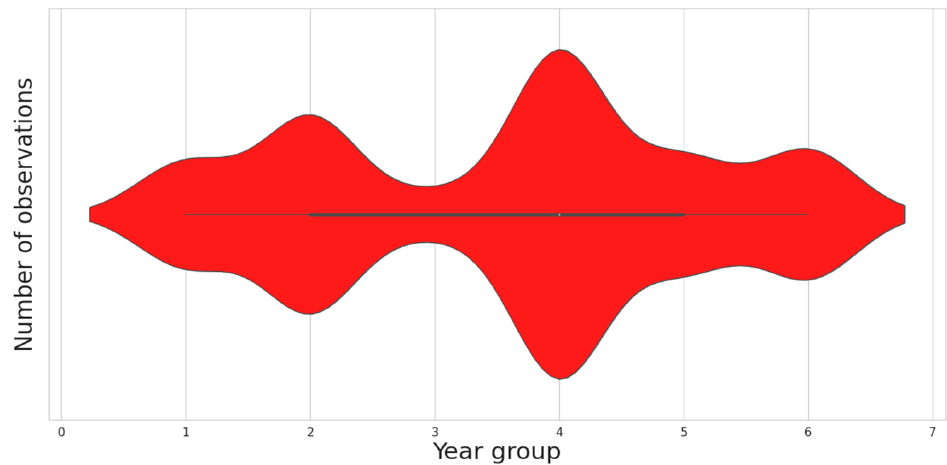
Figure 10. Violin plot of the distribution of interventions in time.